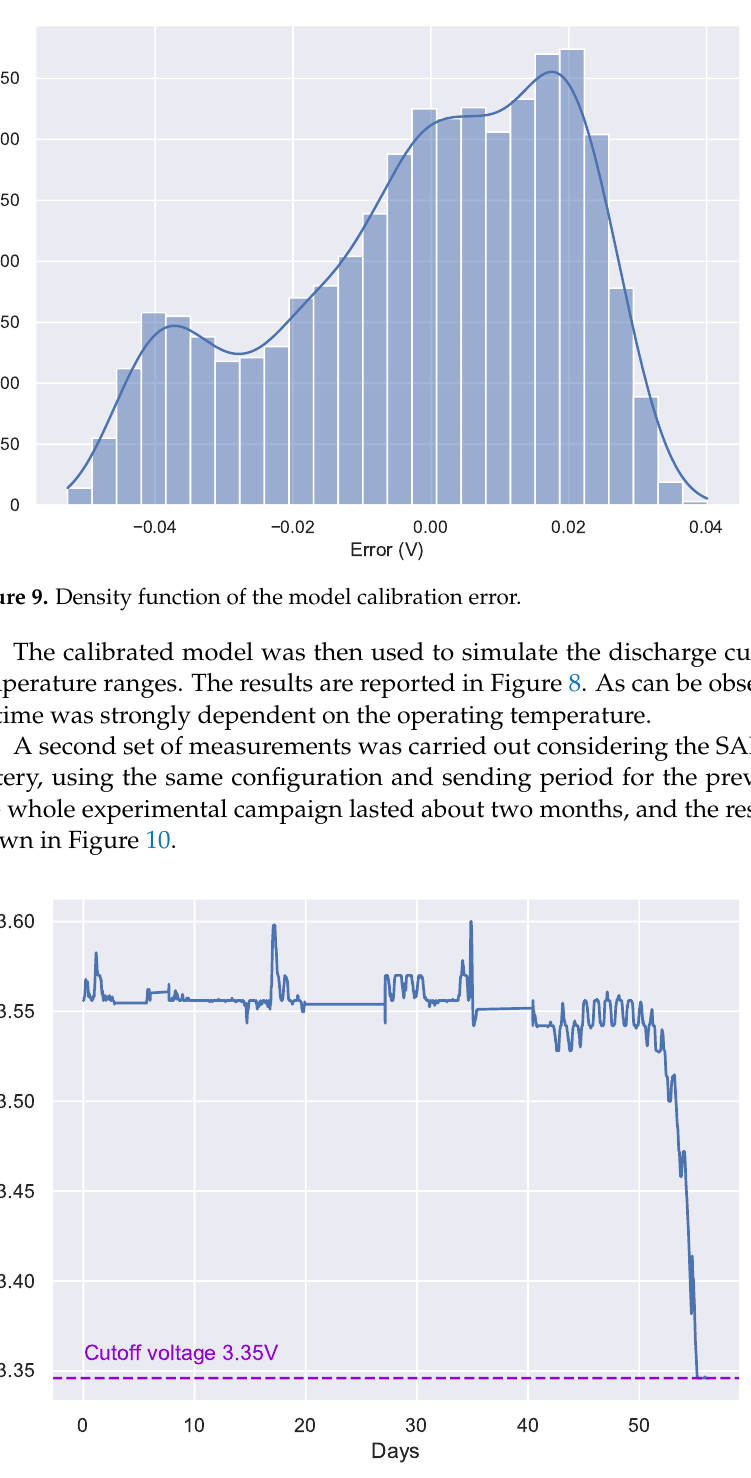
Figure 10. Tinovi PM-IO-5-SM battery lifetime estimation. Experimental discharge curve for a trans- mission period of 5 min and LTC